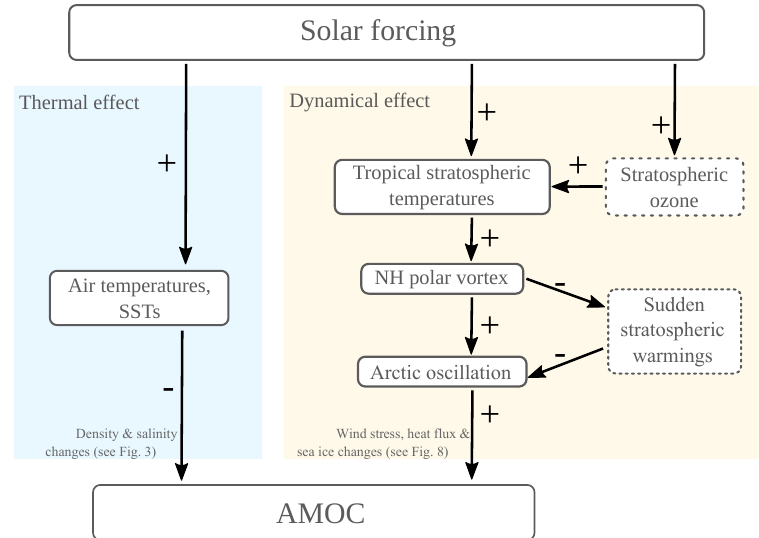
Figure 9. Flowchart summarizing the thermal and dynamical effect of a change in solar radiation on the AMOC. The signs indicate the correlation between two processes. Dashed boxes represent effects which are amplified by chemistry–climate interactions.